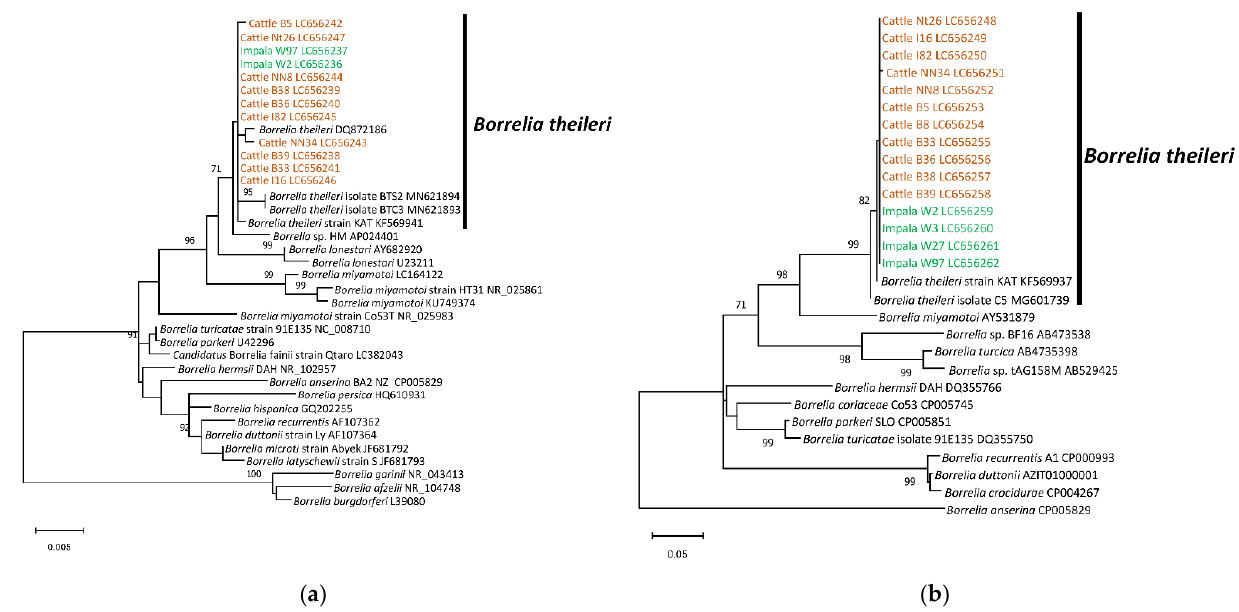
Figure 2. Phylogenetic trees of Borrelia spp. based on the sequences of 16S rDNA and hpt : ( a ) 16S rDNA; ( b ) hpt . The accession numbers for nucleotide sequences are shown after the species names. The analyses were performed using the maximum likelihood method. Bootstrap values > 70% based on 1000 replications are presented on the interior branch nodes.